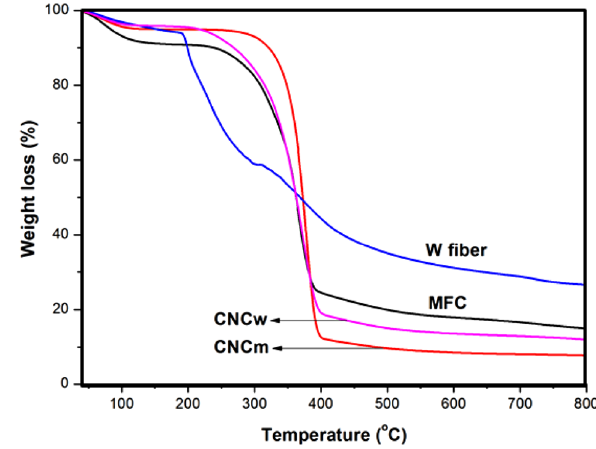
Fig. 3 FTIR spectra of the water hyacinth fibers (W fiber), the micro- fibrillated cellulose (MFC), the W-based cellulose nanocrystals (CNC w ), and the MFC-based cellulose nanocrystals (CNC m )